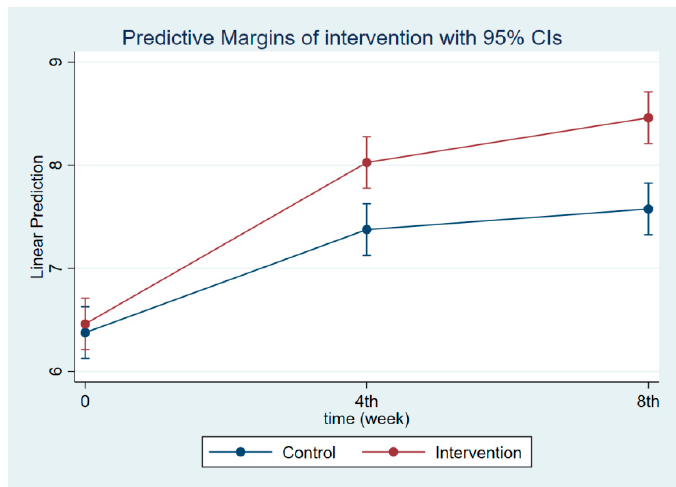
Figure 5. Maternal practice regarding CGM at follow-ups 1 and 2.